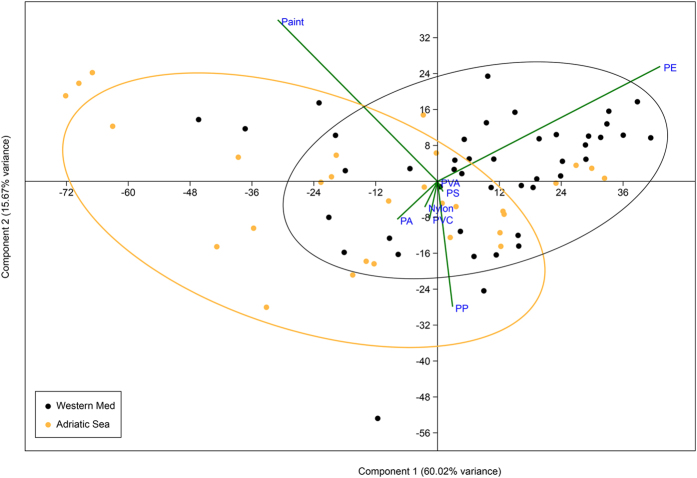
PCA ordination based on the occurrence of the seven most common polymer typologies.All 74 samples are plotted in relation to the first two principal components (PC1 and PC2). Orange dots represent Adriatic samples (n = 30) while western Mediterranean samples are in black (n = 44). Distance biplot of the eigenvectors (not in scale with data points) is shown to help with the interpretation of the loadings results.